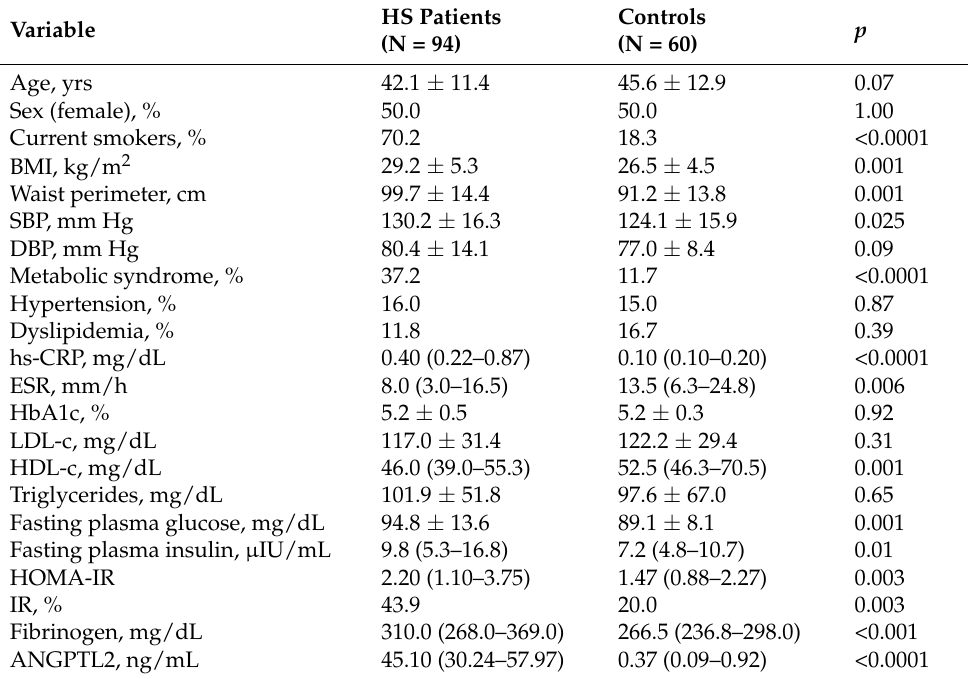
Table 1. Baseline demographic, clinical, and laboratory findings of HS patients and